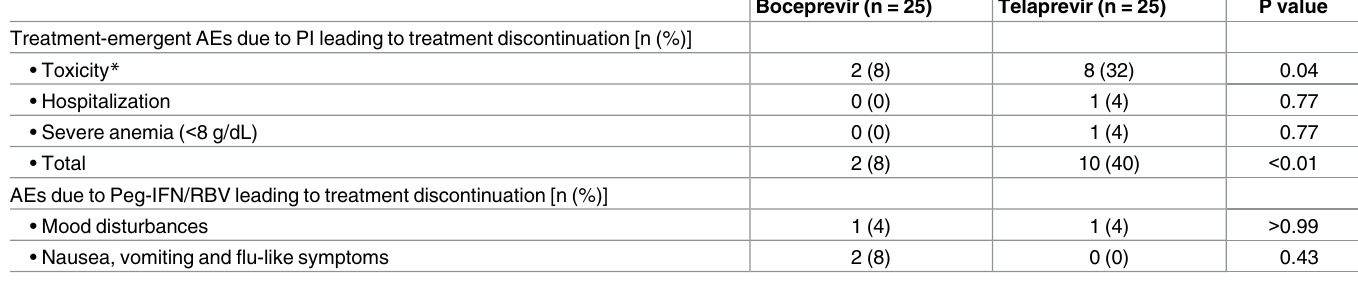
Table 2. Tolerability of boceprevir and